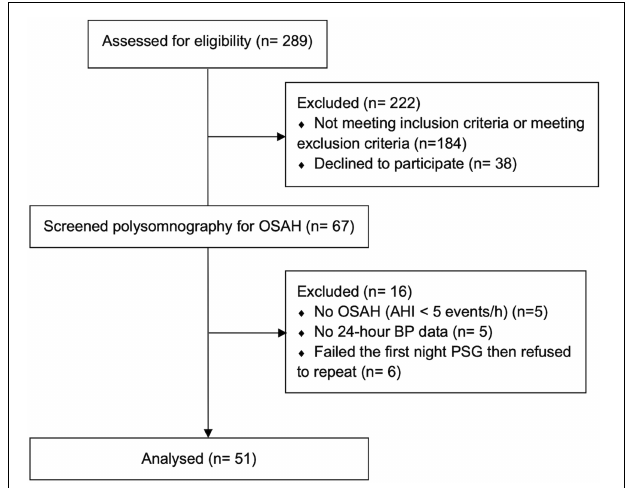
FIGURE 1 | Enrollment flow